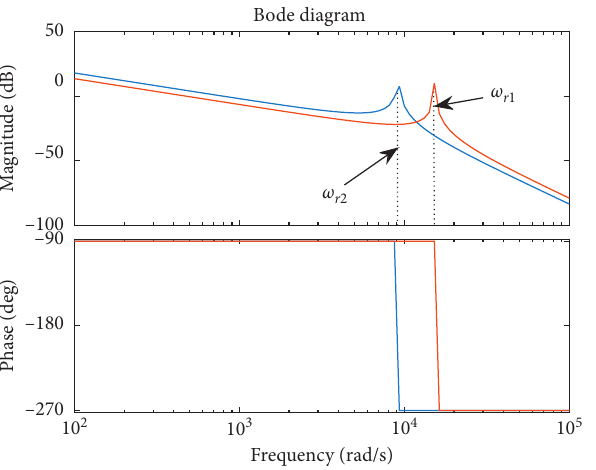
Figure 3: Bode diagram of the transfer function Y ( s ). Table 1: Grid system parameters.